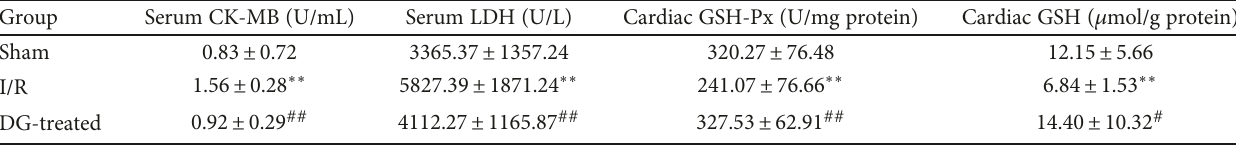
Table 2: E ff ect of Dunye Guanxinning on serum CK-MB, LDH, and cardiac GSH-Px activity and GSH content. Group Serum CK-MB (U/mL)